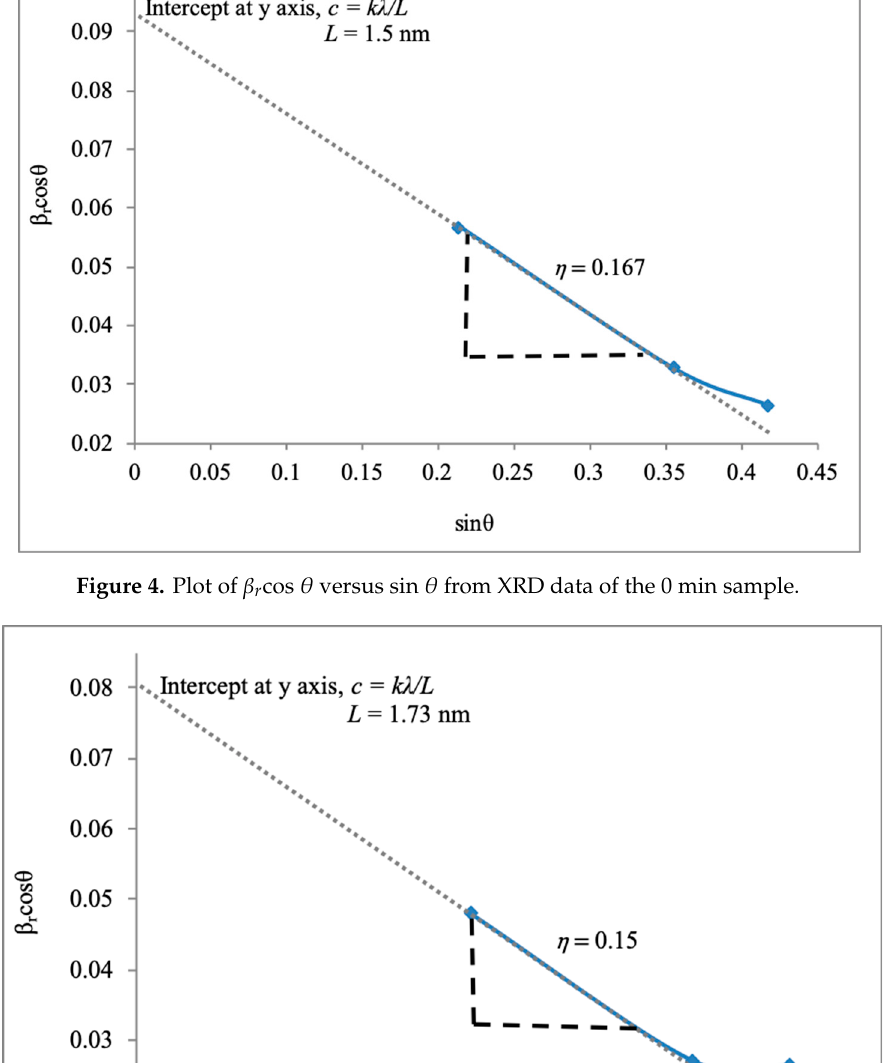
Figure 6. Plot of β r cos θ versus sin θ from XRD data of the 0.5 min sample.